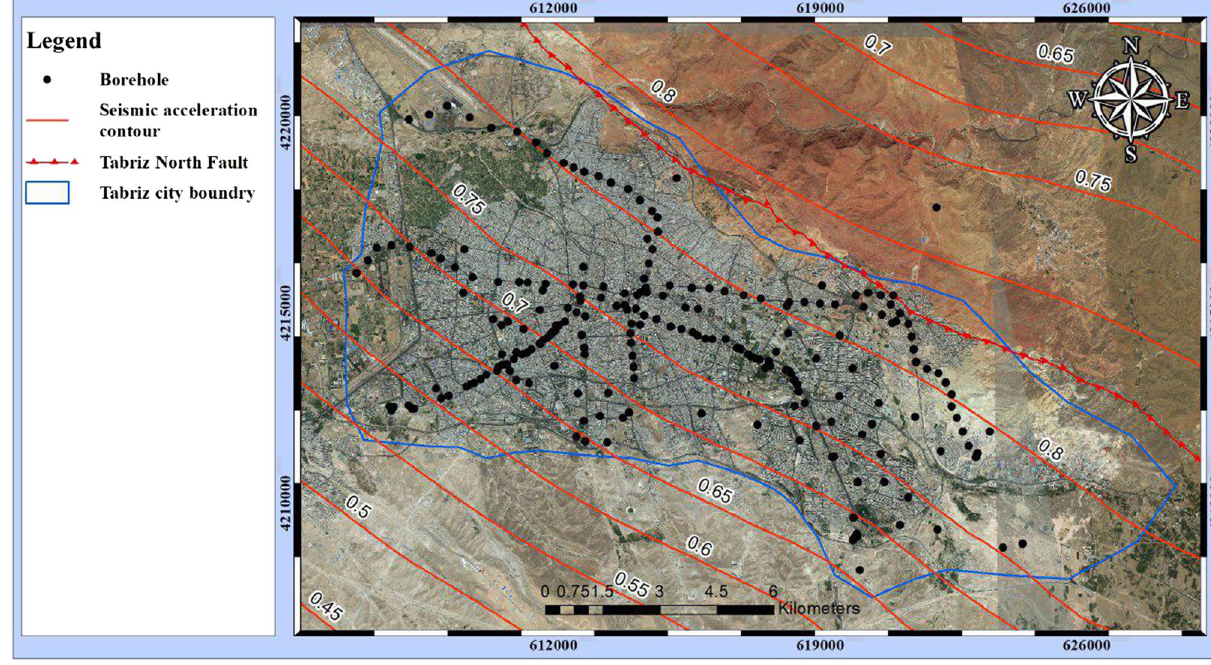
Fig. 12 The positions of the boreholes with curves of PGA values in the study